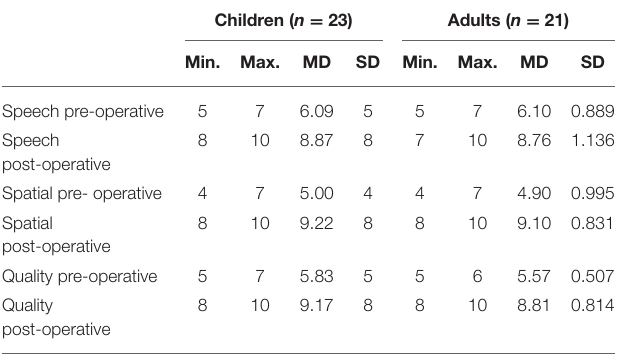
TABLE 4 | Speech, Spatial, and Qualities of Hearing Scale questionnaire results of the children and adult single-sided deafness groups ( p > 0.05). Children ( n = 23) Adults ( n = 21) Min. Max. MD SD Min. Max.